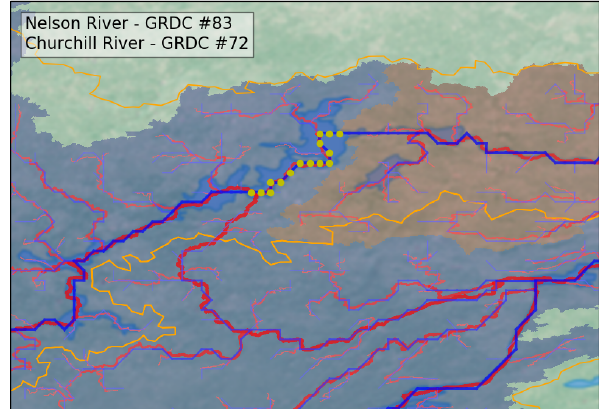
Figure 7. Region surrounding the South India Lake in Canada where the river network has been corrected to follow the natural outlet of the lake to the Churchill River. Blue and red lines represent the river network at 12D and HR (MERIT-Hydro), respectively. The yellow line corresponds to the Nelson River and Churchill River delineation from GRDC. The yellow circles show the cells where the flow direction has been inverted to reconnect the lake to the Churchill River. The blue and red background masks correspond to the Nelson River and Churchill River basins extracted from MERIT- Hydro, respectively.